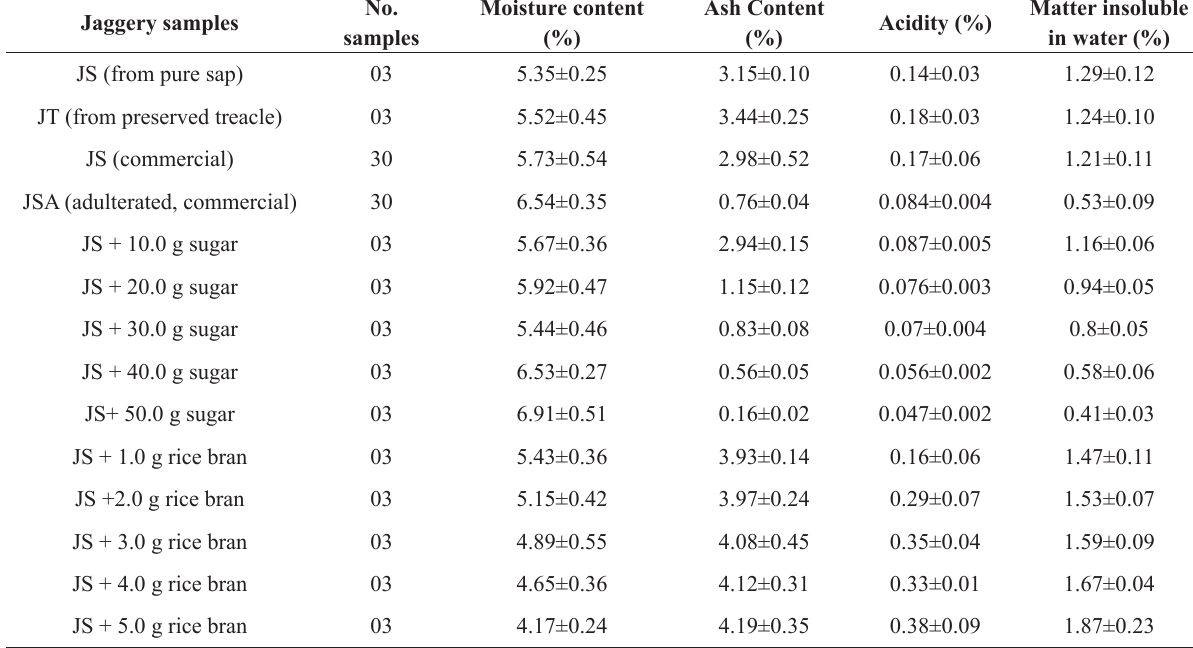
Table 1: Quality characteristics of palmyrah jaggery. Jaggery